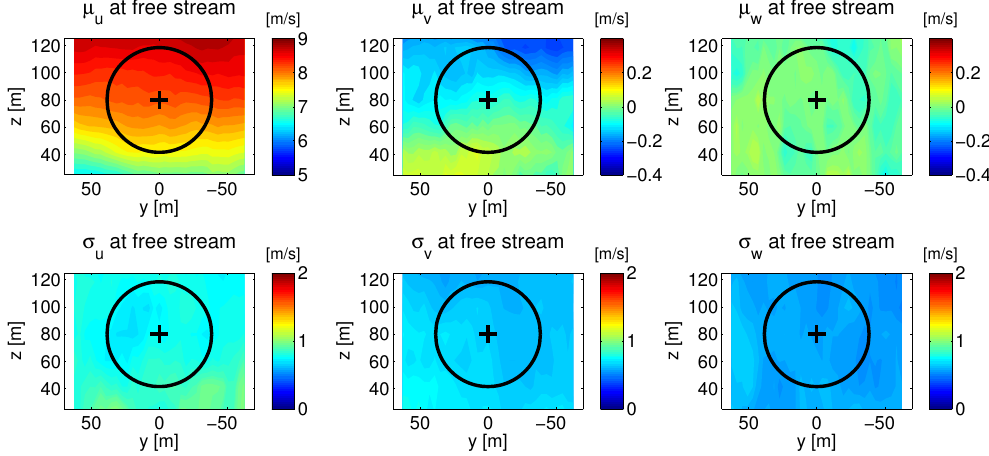
Figure 3. Variation in a vertical plane of the free-stream wind velocity mean and standard